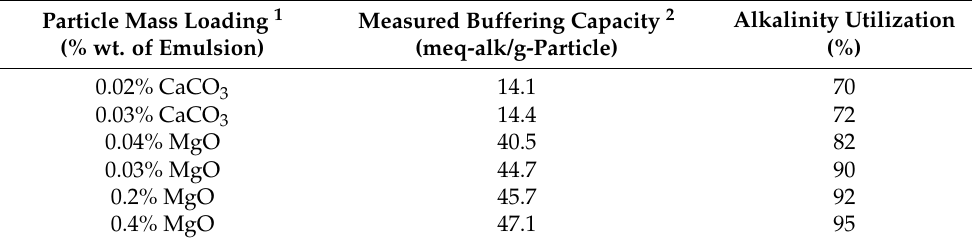
Table 2. Buffering capacity and alkalinity utilization of emulsions containing CaCO 3 and MgO